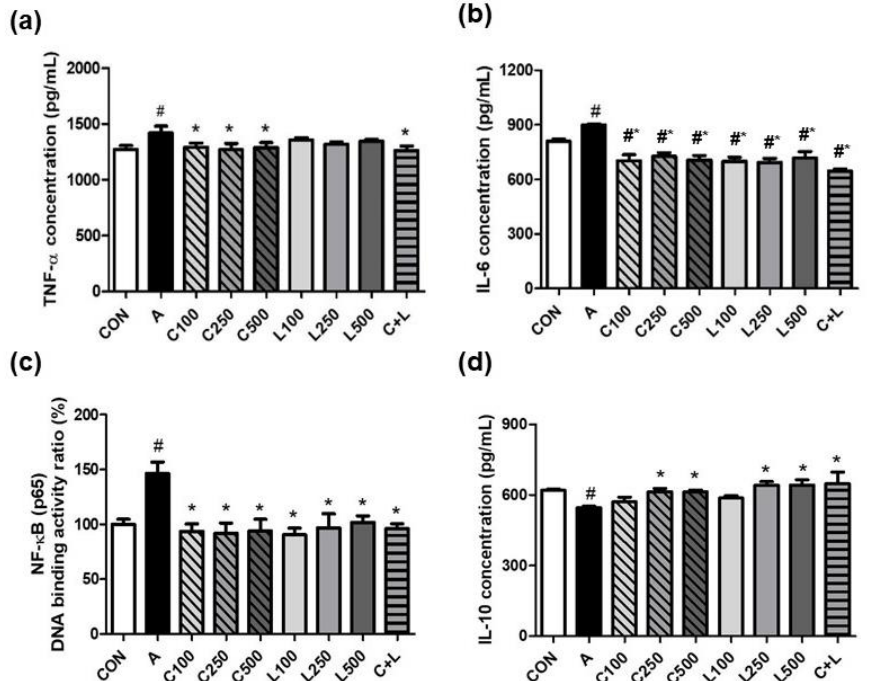
Figure 2. Effects of aspirin, CPC, and/or LBP on proinflammatory markers ( a ) TNF- α , ( b ) IL-6, ( c ) NF- κ B (p65) DNA binding activity ratio, and anti-inflammatory marker ( d ) IL-10. CON: control group, A: aspirin-induced group, C: CPC treated group, L: LBP treated group. Data are mean ± SD ( n = 3). # p < 0.05 compared with the CON group. * p < 0.05 compared with the A group.